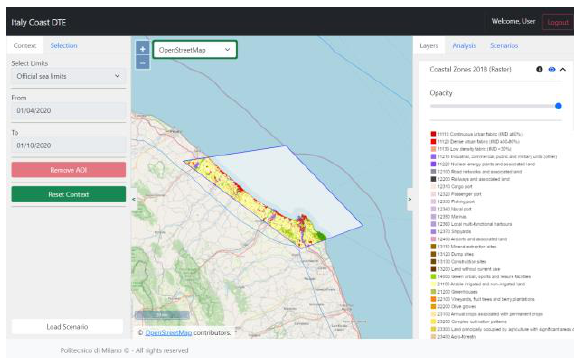
Figure 5 . Application user